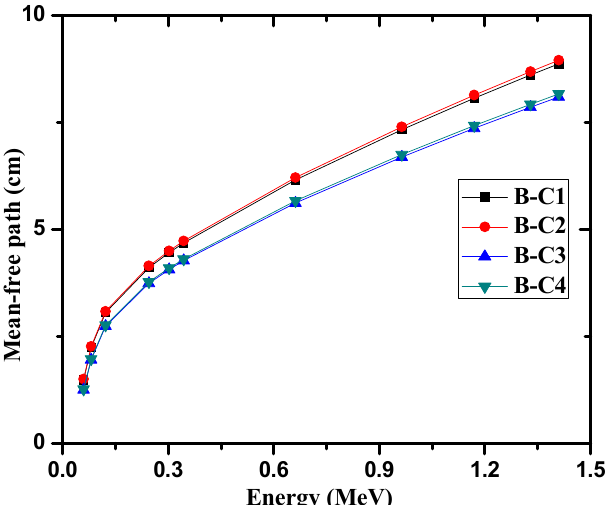
Figure 4. The mean-free path of the four investigated samples at different energies. The mass attenuation coefficient for the compared shielding materials is almost the same, as shown in Table 4, because this parameter is not affected by the density of the absorber material. The results demonstrated that the current samples have the same shielding ability as ordinary concrete and the same thickness needed to reduce the initial